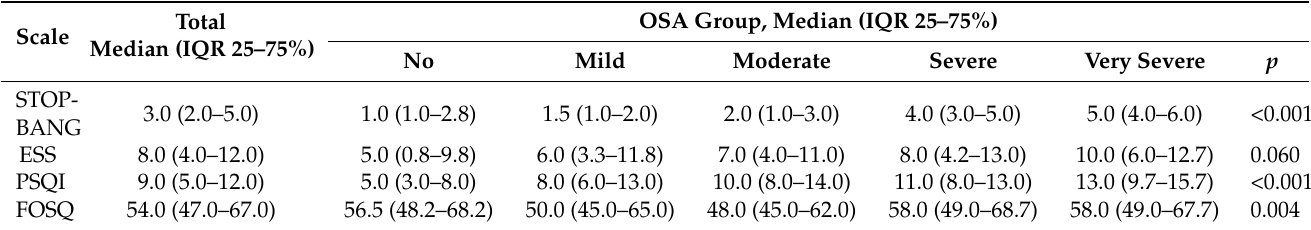
Table 3. Sleep questionnaire responses for the study sample and across OSA severity groups.